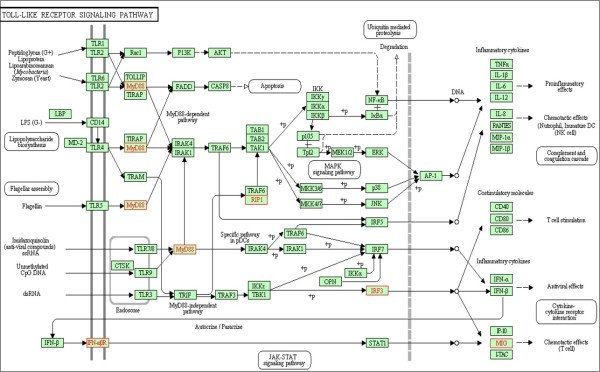
Toll-like receptor signaling pathway figure supplied by KEGG [[34]]. The genes of module 2 reported in this study (see Results section in the main text) are in red.